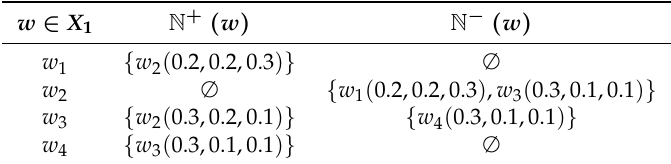
Table 3. IN-out and in-neighborhoods of −→ G 1 .